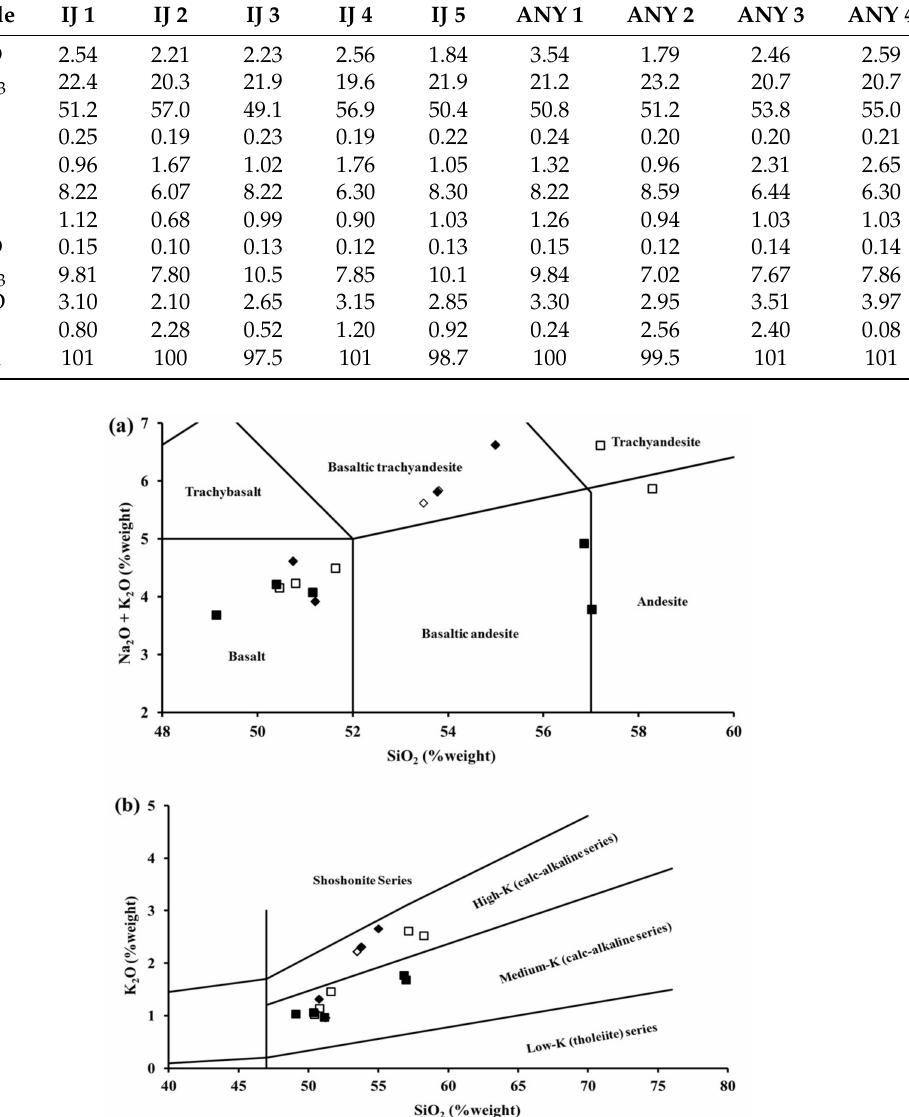
Figure 2. ( a ) Silica oxide (SiO 2 ) plot versus sodium oxide (Na 2 O) and potassium oxide (K 2 O) [34]; ( b ) Plot of SiO 2 versus K 2 O [35,36]. Symbols: filled square—Ijen Crater (Il3), filled diamond—Mount Anyar (Al), hollow square—Ijen Crater [27], and hollow diamond—Ijen Crater